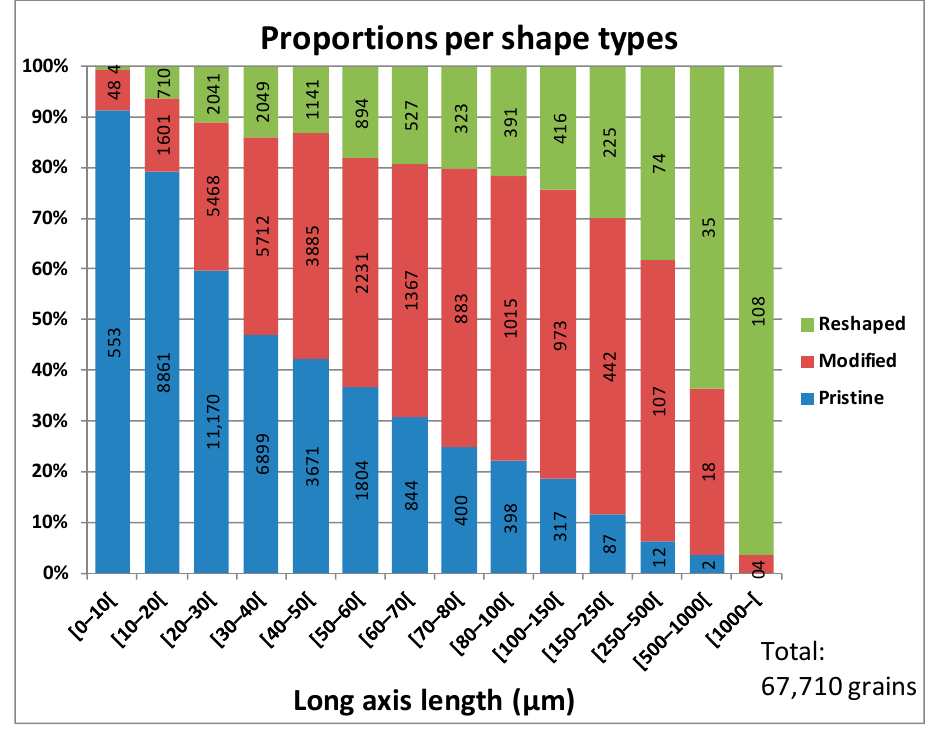
Figure 17. Proportions of “pristine,” “modified” and “reshaped” grains in till according to their size. The diagram is based on a subset of 67,710 grains, all classified from BSE images using the same version of ARTMorph routine. The constant decrease in “pristine” grain abundance with size is stark, ranging from 92% in grains smaller than 10 µ m, to 0% for grains larger than 1 mm. Note that the scale axis is linear up to 100 µ m, after which it becomes approximately logarithmic. At the typical median size of 20–30 µ m, approximately 60% or the grains are “pristine,” which is close to the overall average of the database.